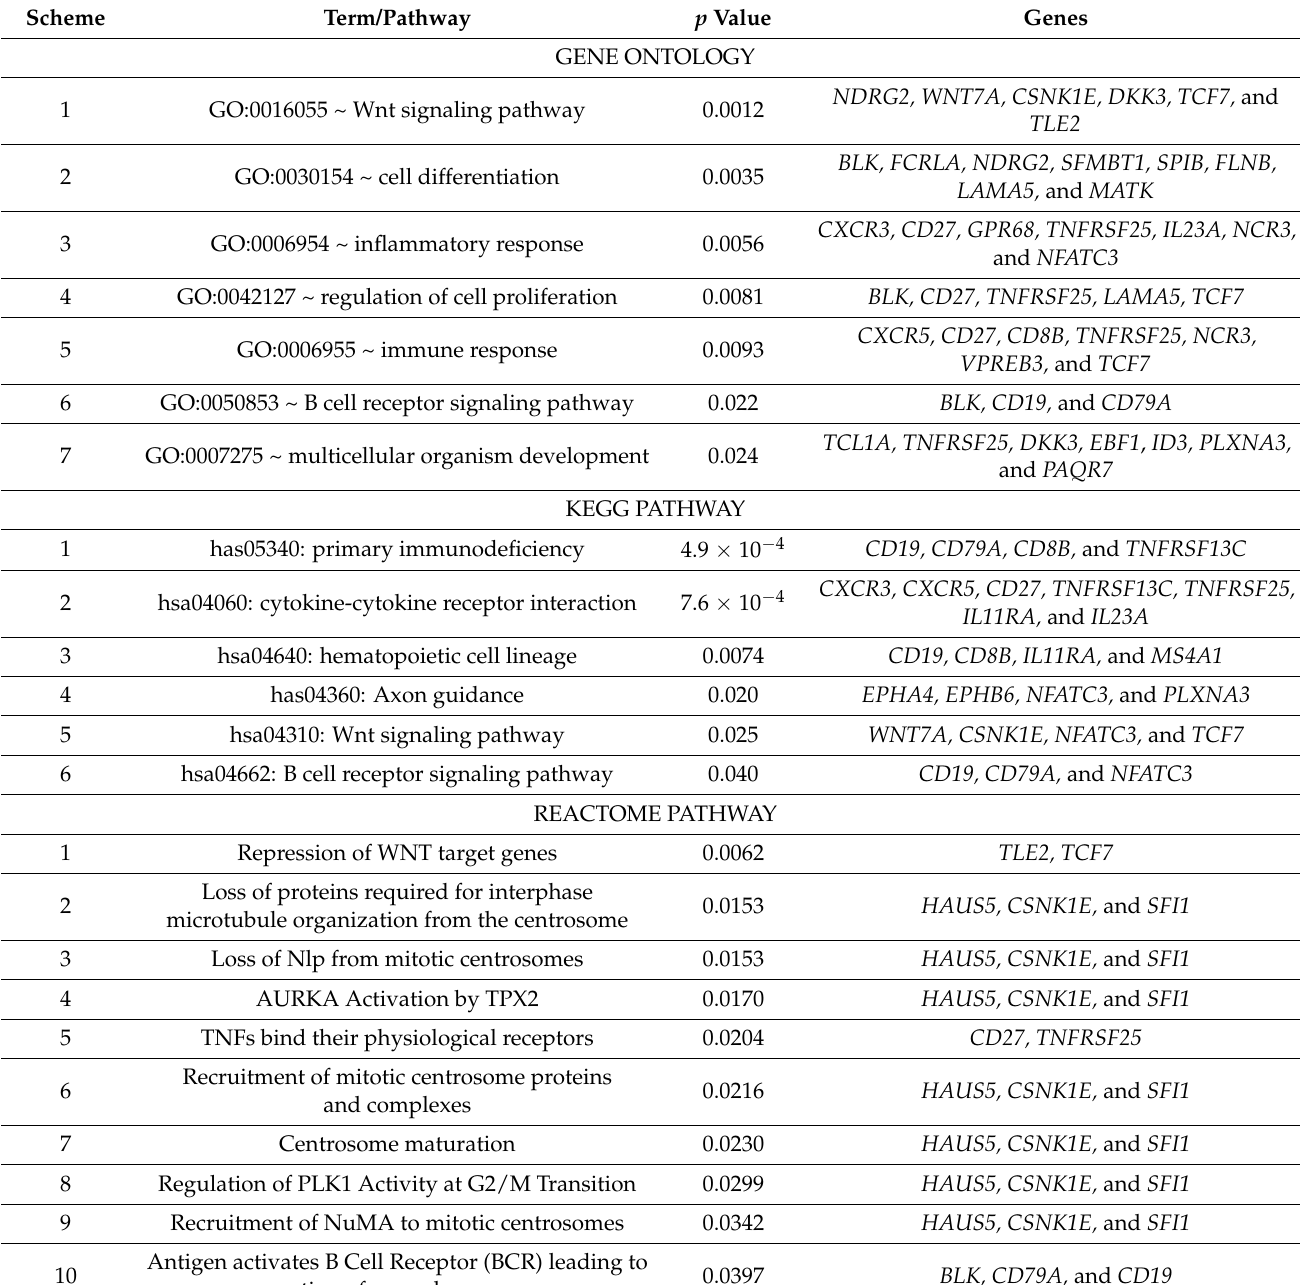
Table 3. Gene ontology and pathway enrichment analysis of downregulated